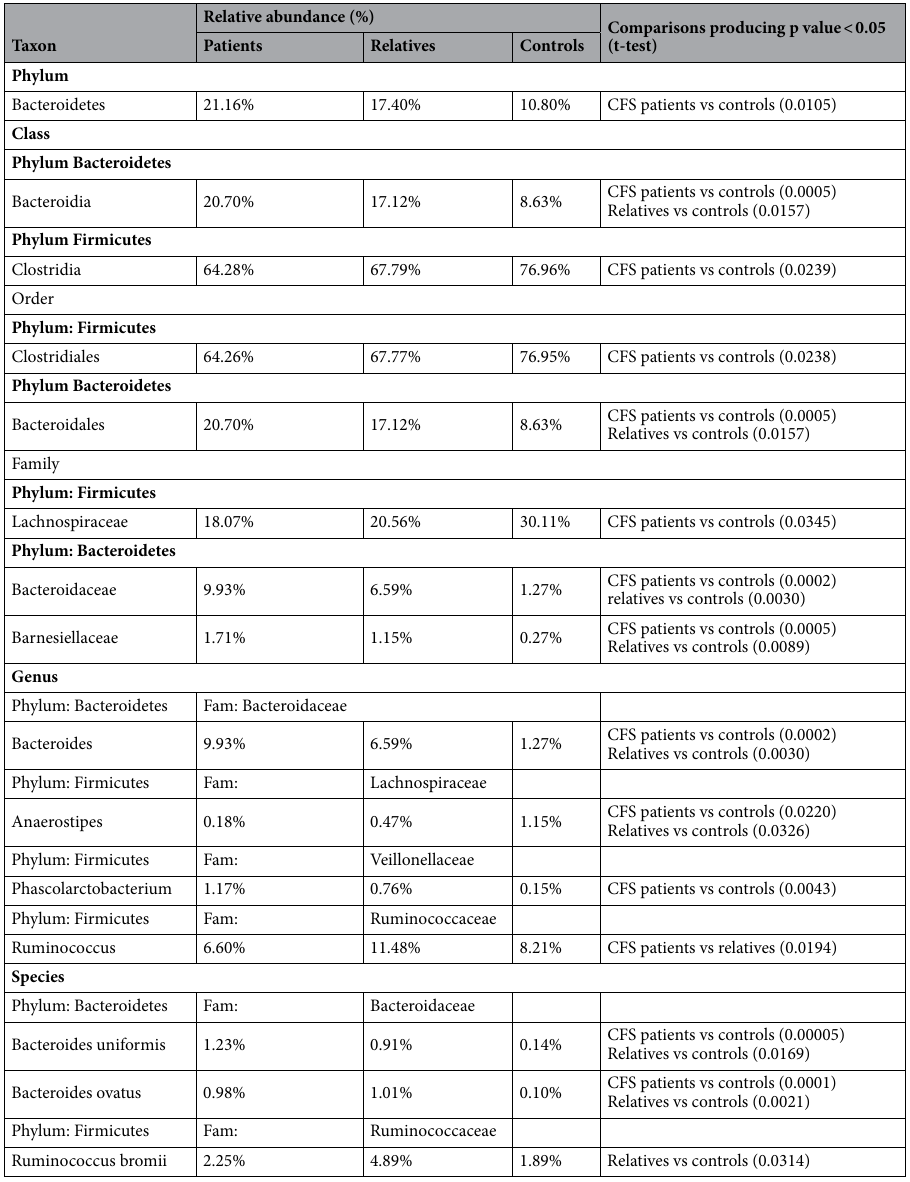
Table 3. Significant differences in bacterial taxa abundances in fecal samples of the three experimental groups. The relative abundances are reported as average abundance values of each group. Student’s t-test and post hoc Bonferroni correction were applied to determine any significant difference in the relative abundances of intestinal bacterial taxa between groups.